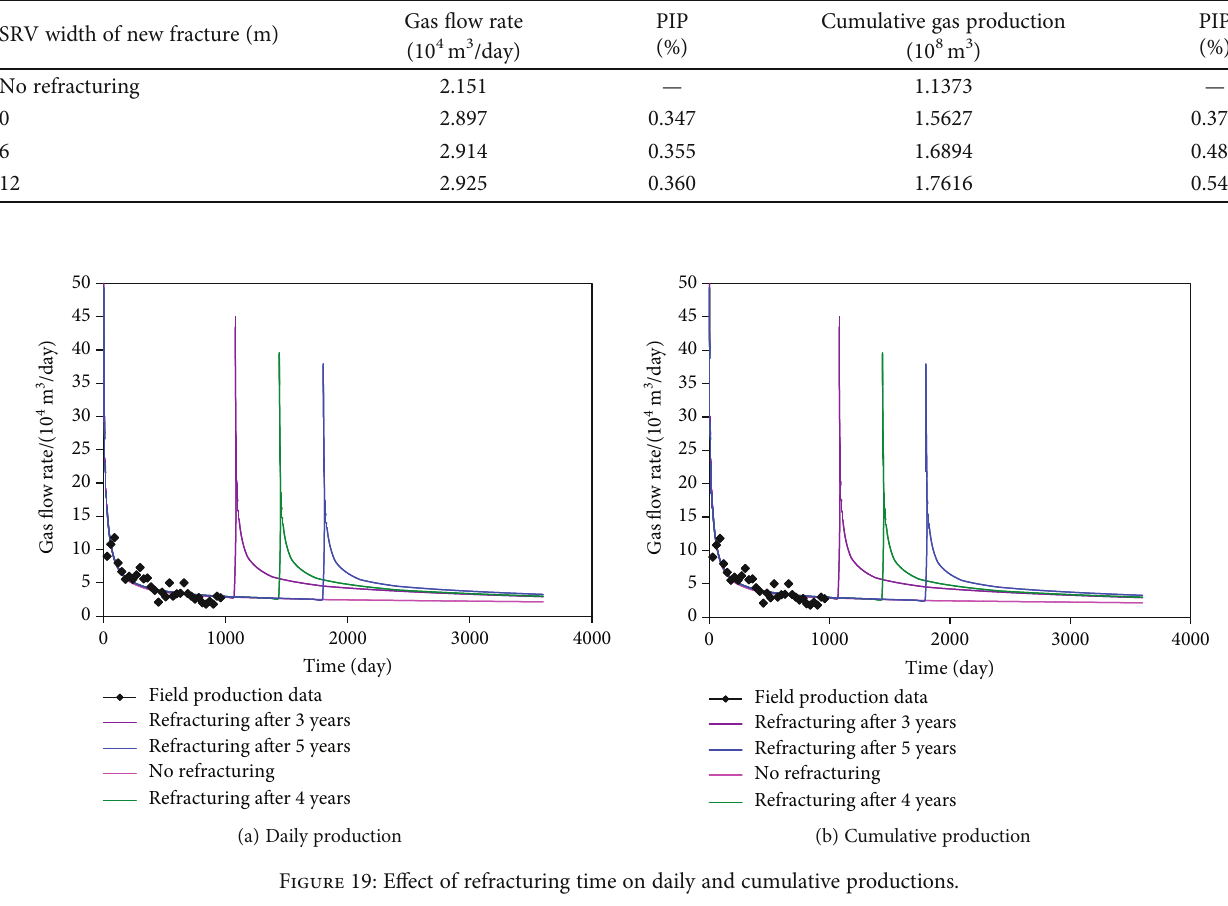
Table 8: Production increase percentage with di ff erent SRV widths of refractured new fracture.